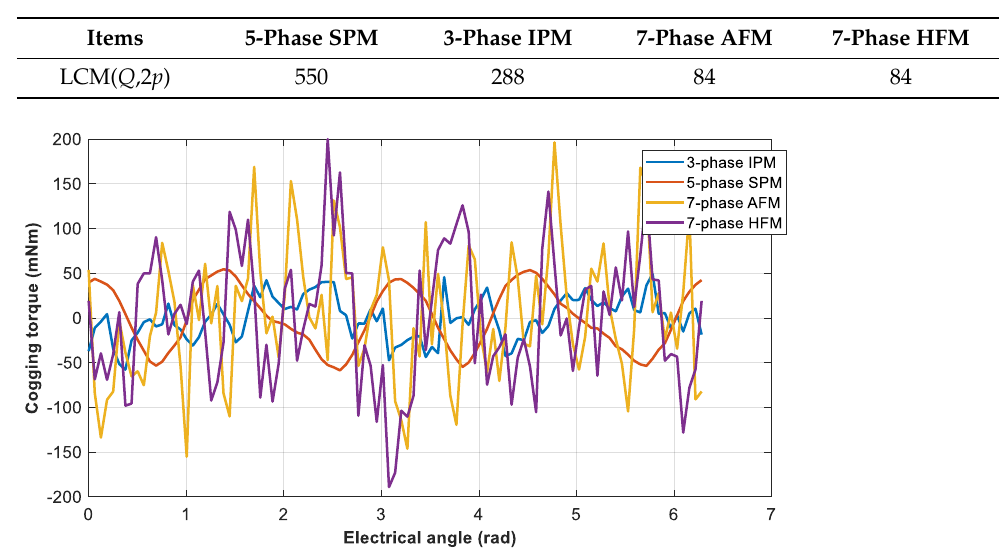
Figure 8. The cogging torque of the four machines. Table 2. LCM of the four machines.